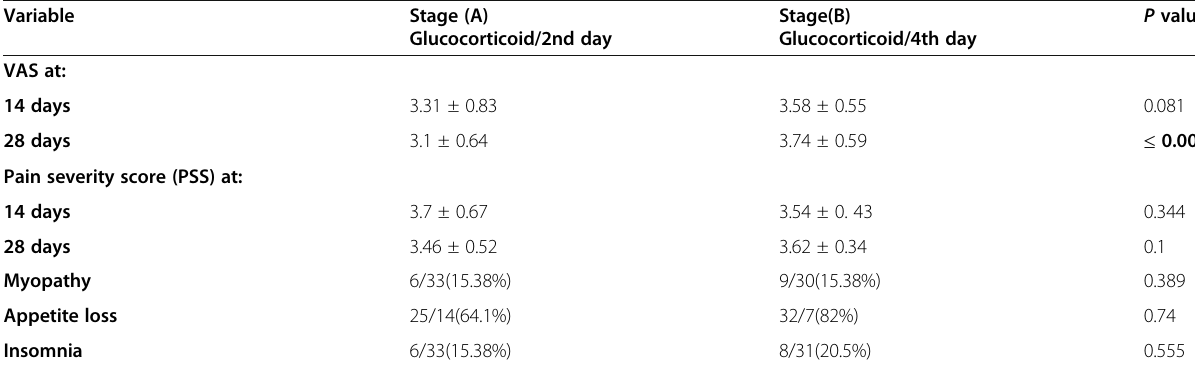
Table 4 Study stages comparison; pain scores, and side effects